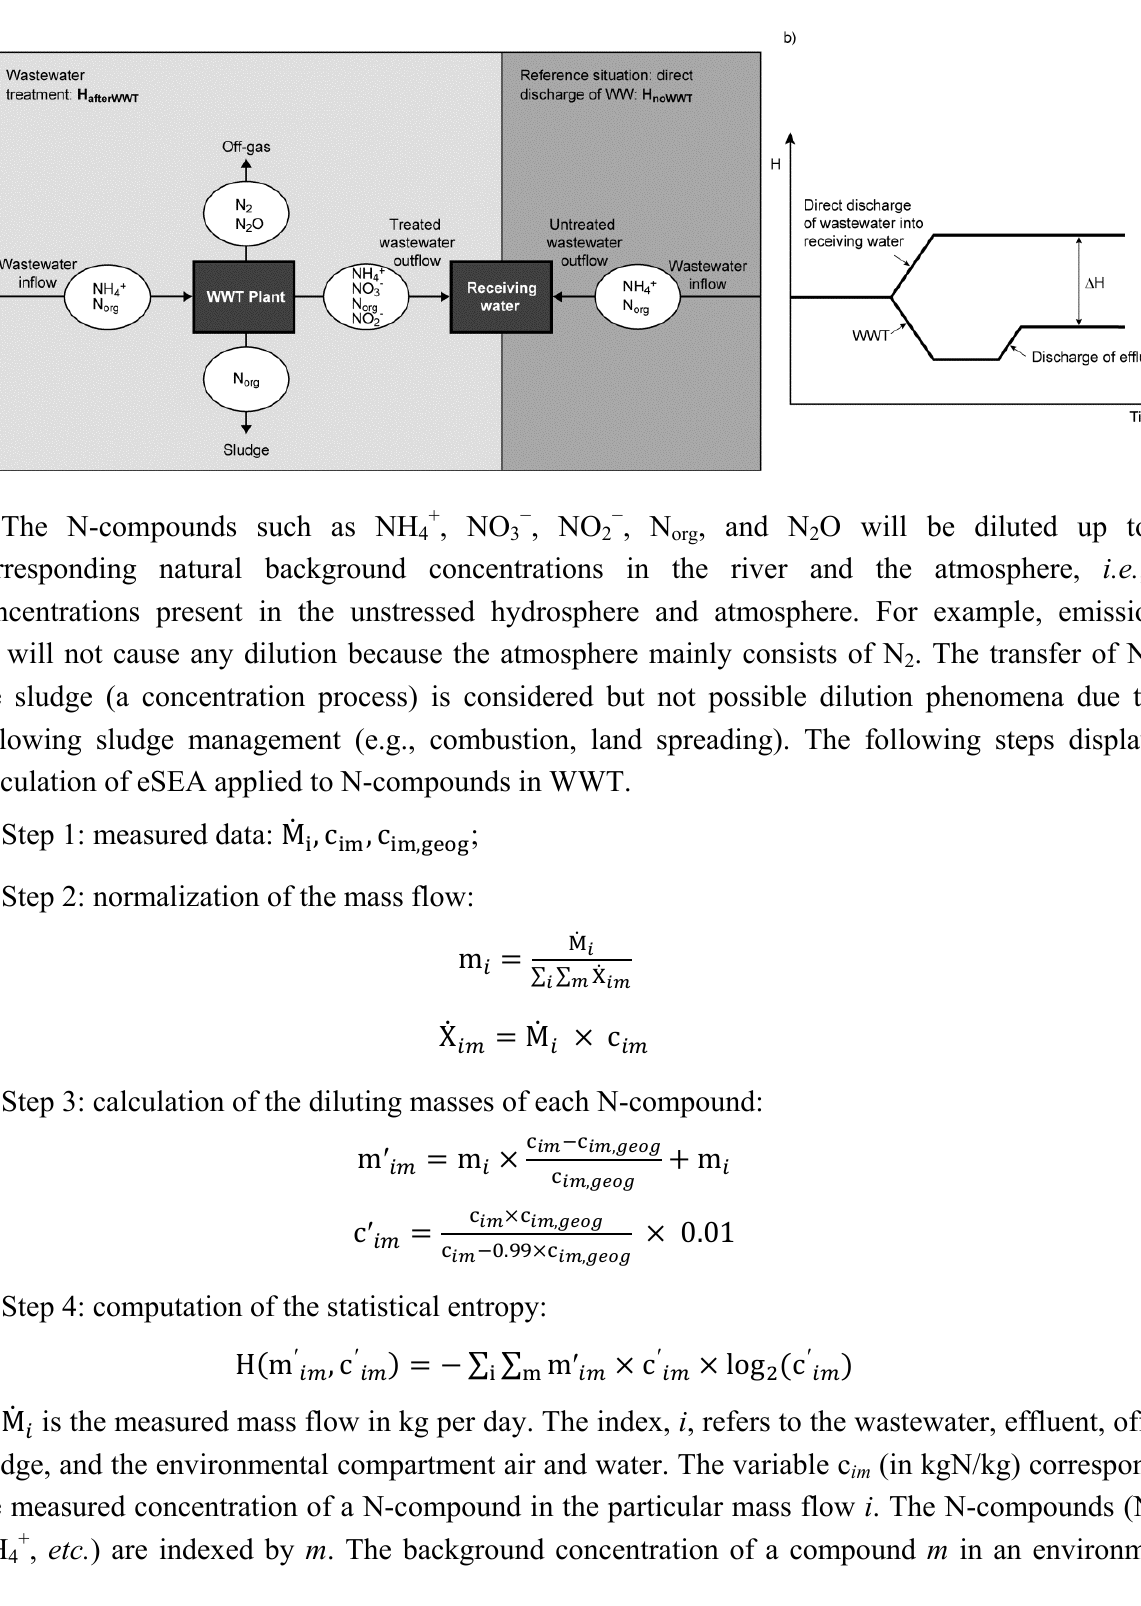
Figure 1. ( a ) Left: Schematic illustration of N-compounds as occurring in the WWT process; Right: reference situation: wastewater is discharged untreated into the receiving waters; ( b ) Direct discharge of wastewater to the hydrosphere results in an entropy increase. WWT reduces the entropy, discharge of the effluent to the receiving water results in a (small) increase. Δ H quantifies the cleaning performance of the WWT